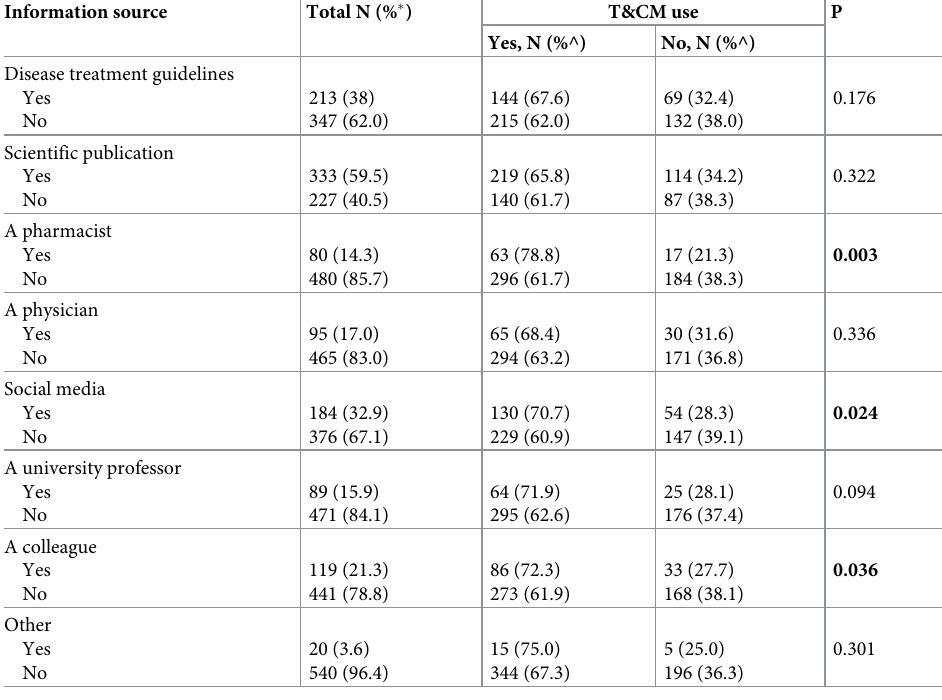
Table 4. Sources of information regarding T&CM use for COVID 19 prophylaxis and their association with actual T&CM use.